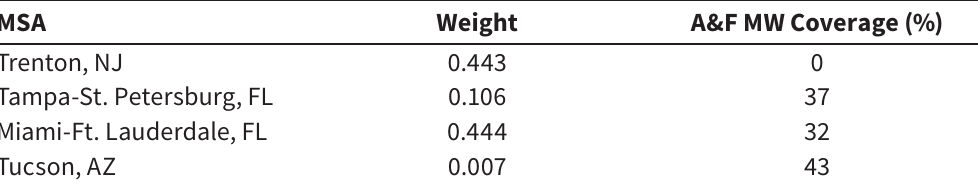
Weights for Constructing Synthetic Accommodation and Food Industry